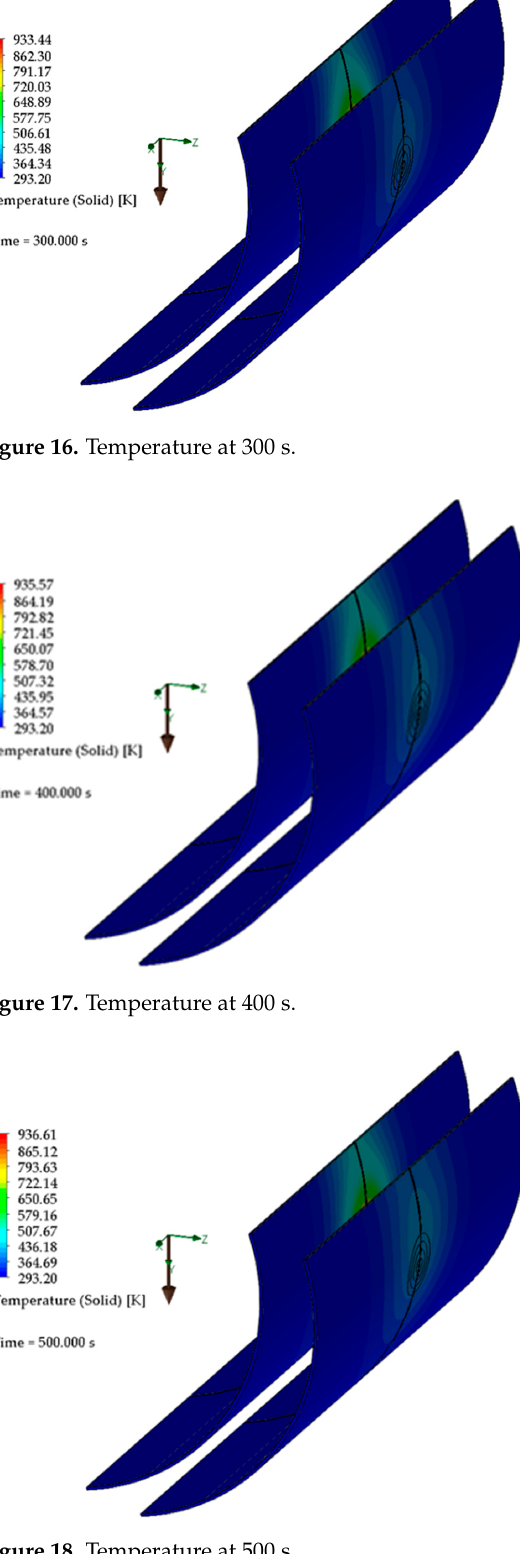
Figure 15. Temperature at 200 s.